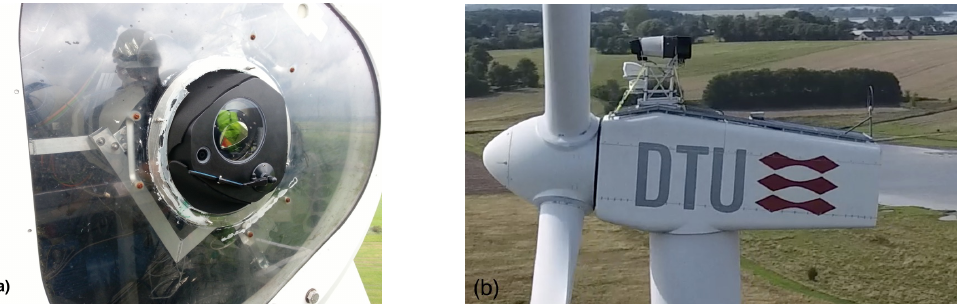
Figure 1. Examples of the two different installation modes of the SpinnerLidar used for measuring the inflow of a wind turbine: ( a ) integrated in the spinner of the rotor of an NM80 wind turbine and ( b ) installed on the nacelle of a V52 wind